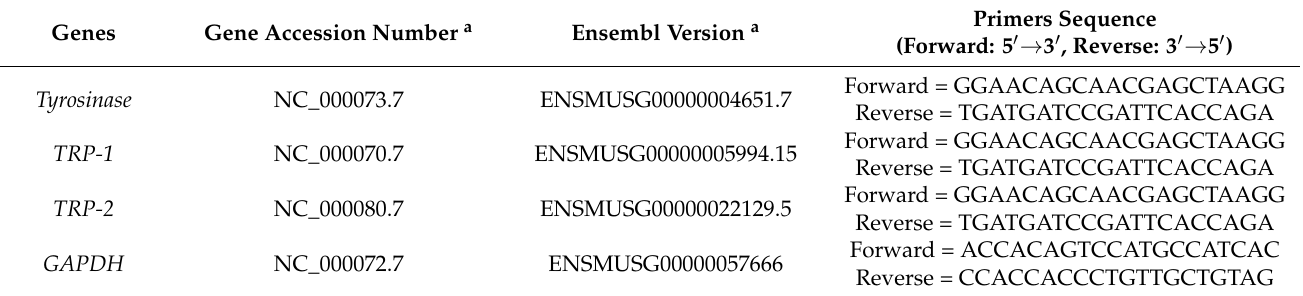
Table 1. List of primer sets used for